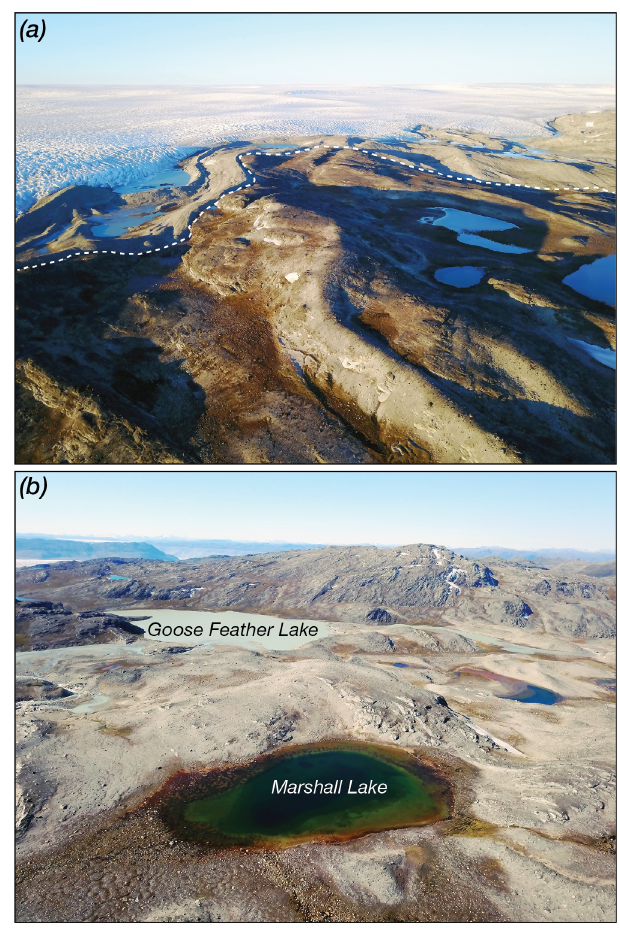
Figure 4. (a) View to the northeast in the Qamanaarsuup Sermia region (Fig. 3). In the foreground is a Kapisigdlit stade moraine crest resting directly adjacent to the historical maximum extent of this sector of the GrIS (dashed line). The GrIS is in the background, and there has been minimal retreat from the historical maximum extent here. (b) View to the southwest in the Qamanaarsuup Sermia region showing Marshall Lake and Goose Feather Lake. Note the color contrast between the two lakes. Marshall Lake currently does not receive meltwater from the GrIS. Goose Feather Lake is cur- rently a proglacial lake that receives silt-laden GrIS meltwater; the lake catchment currently extends beneath the modern GrIS footprint (Figs. 3a and